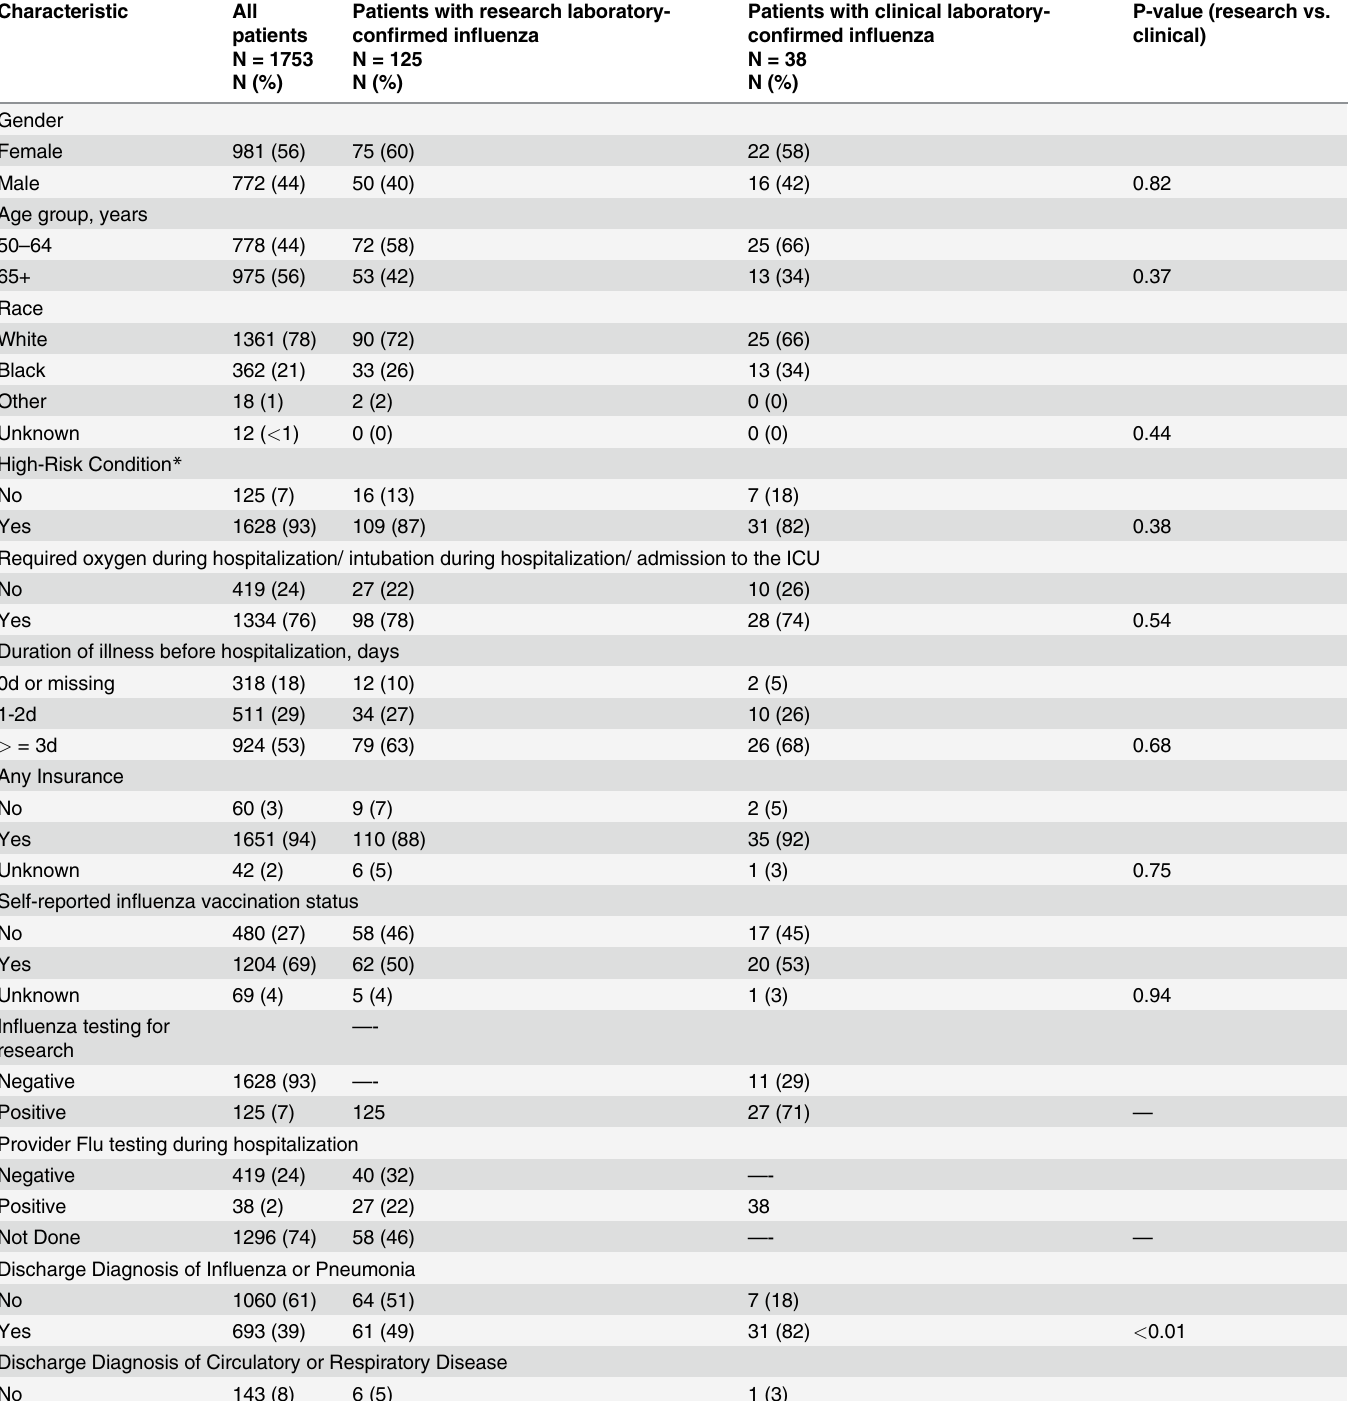
Table 1. Characteristics of Adults 50 years and older Hospitalized with Symptoms of Respiratory Illness or non-localizing Fever during 2006 – 2012 Influenza Season.